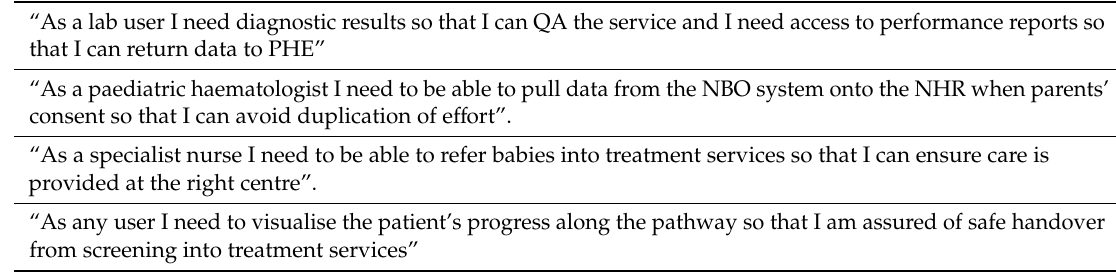
Table 4. Examples of user